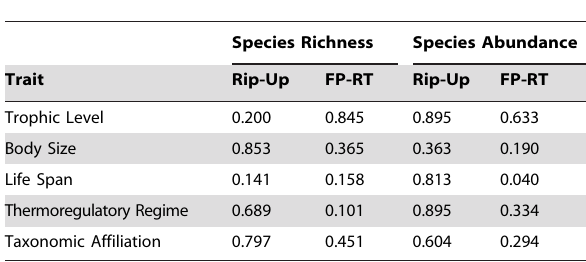
Table 4. Kruskal-Wallis test results (p-values) for between- habitat type or between-zone effect size differences based on the biological groups described in the Supporting Information: Table